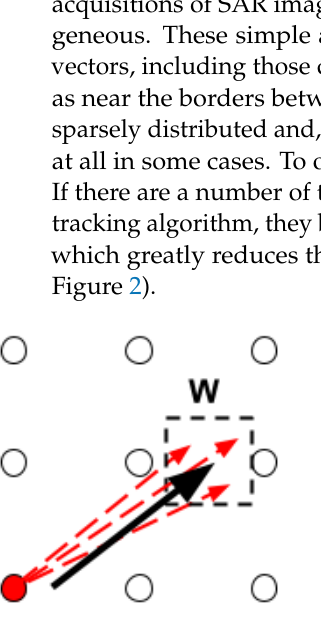
Figure 2. A guide vector by the feature tracking algorithm (solid black arrow) and an associated search area W defined around the end of the vector (dotted black line). The size of searching zone W is set empirically and is 32 × 32 pixels. The red arrows illustrate potential ice drift vectors for a closest computational grid cell (red circle) by the pattern matching algorithm. The black outlined circles correspond to computational grid points used in the pattern matching